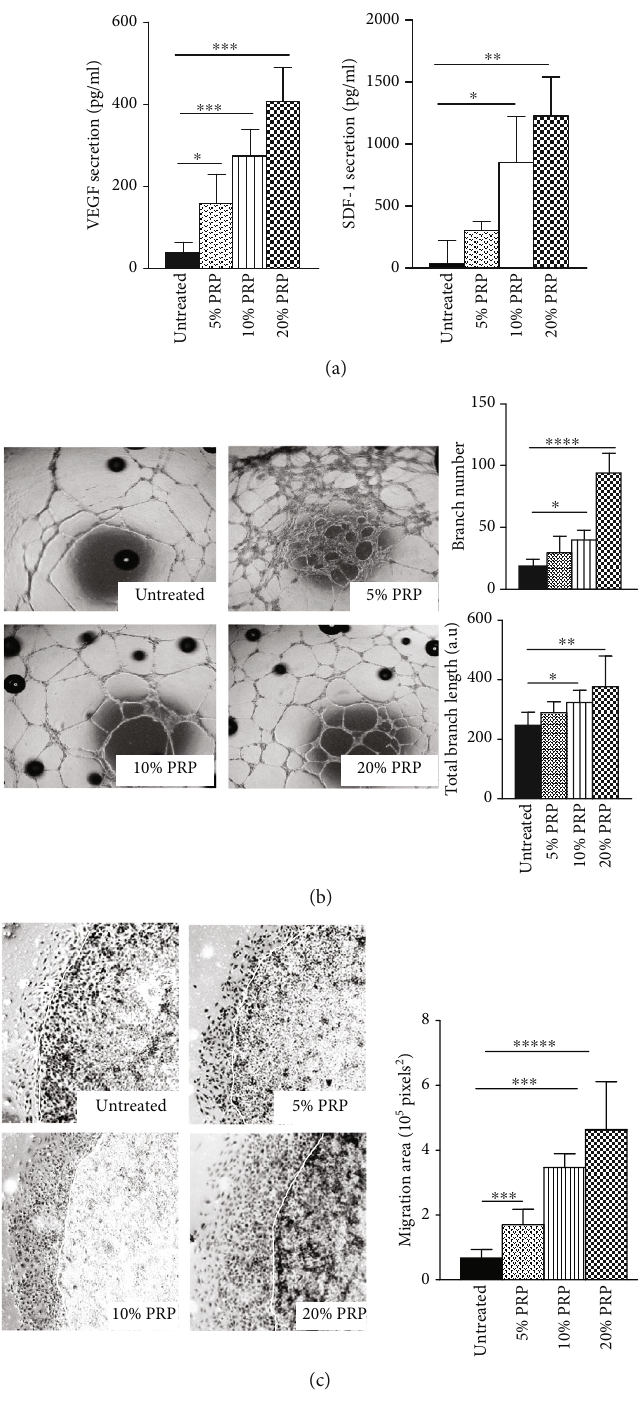
Figure 3: PRP treatment stimulates the proangiogenic properties of hMADS cells in vitro . (a) ELISA quanti fi cation of VEGF and SDF1 in conditioned media from hMADS cells after 24 hours of culture in the absence (untreated) or the presence of at 5%, 10%, or 20% PRP. (b) Left panel: representative images of capillary structures formed by endothelial HUVEC cells following a 48-hour exposure with conditioned media from untreated hMADS cells or hMADS cells treated with 5%, 10%, or 20% PRP. Right panel: capillary branch number and length after a 24-hour exposure of HUVEC cells to conditioned media from untreated hMADS cells or hMADS cells treated with 5%, 10%, or 20% PRP. (c) Left panel: representative images of the edge of agarose beads showing migration of HUVEC cells from agarose drops following a 24-hour exposure with the di ff erent conditioned media (hMADS cells grown in basal medium in the absence of PRP (untreated) or in the presence of 5%, 10%, or 20% PRP). White lines delineate the edge of the agarose droplets. Right panel: migration area quanti fi cation of HUVEC cells following a 24-hour exposure with the di ff erent conditioned media from hMADS cells in the absence of PRP (untreated) and 5%, 10%, or 20% PRP. Data represent mean ± SD of n = 5 independent experiments. ∗∗∗ p < 0 : 001 , ∗∗∗∗ p < 0 : 0001